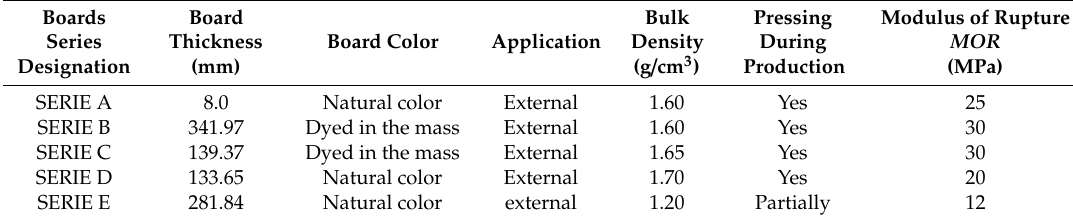
Table 1. Characteristic parameters of individual sample series.